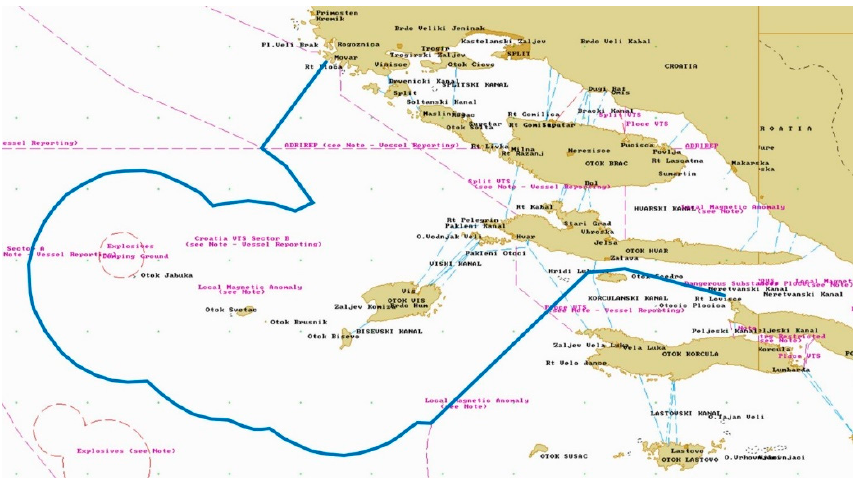
Figure 1. Adapted from [13]; maritime region of Split.